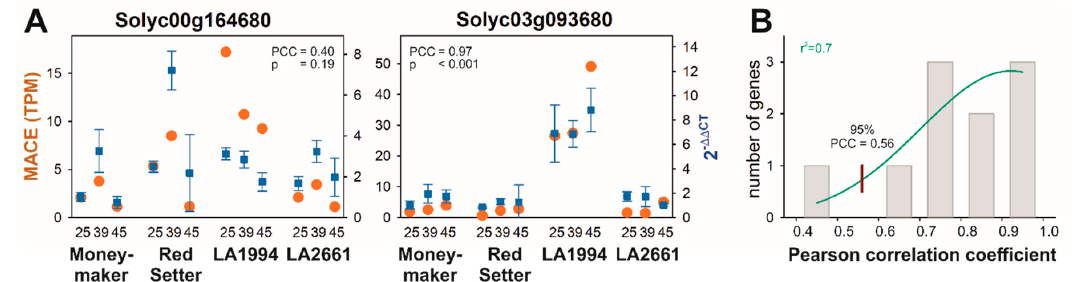
Figure 2. Correlation between Massive Analysis of cDNA Ends (MACE) and quantitative real-time PCR (qRT-PCR)-based transcript abundance quantification. ( A ) The transcript profiles for ten randomly selected genes were determined by MACE (TPM) or by qRT-PCR (2 −ΔΔ CT ). The results for the lowest correlation (left) and the highest correlation are shown (right); other examples are in Figure S1. ( B ) The Pearson correlation coefficient (PCC) between MACE and the qRT-PCR profile was determined (grey bars) and its distribution analyzed by a Gaussian (green line). The red line indicates the PCC which occurs with 95% confidence. The r 2 value for the least-square fit analysis is